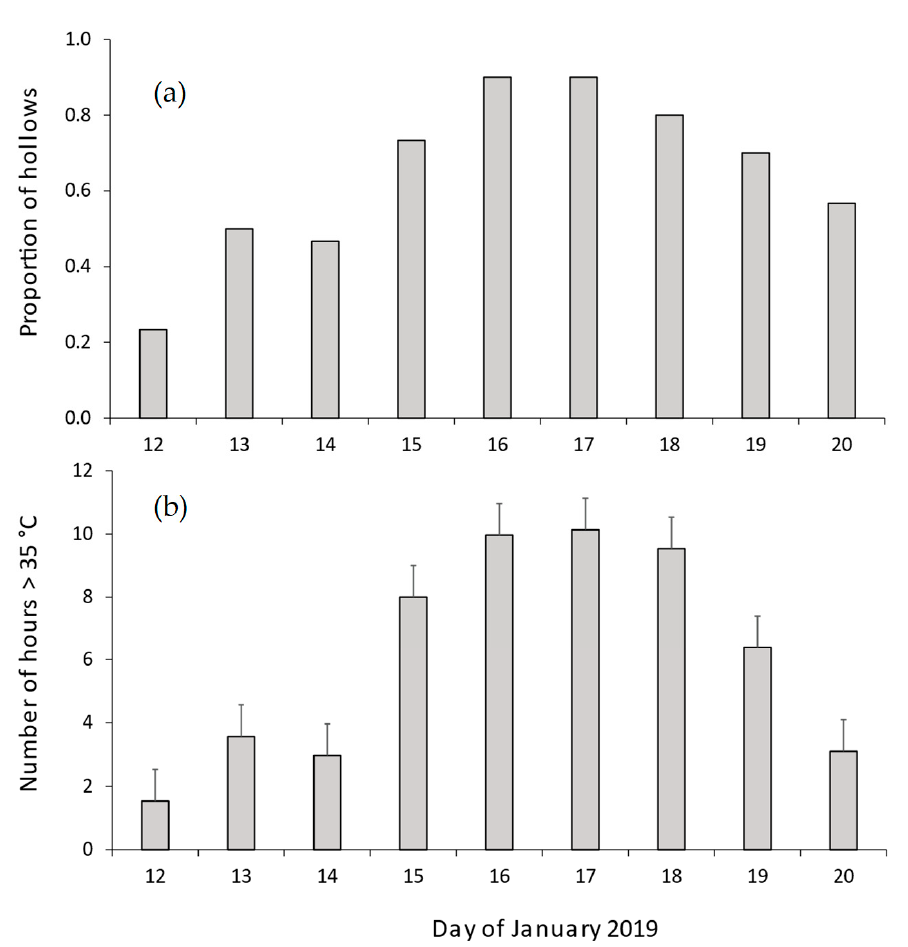
Figure 5. Thermal characteristics of CHs during the January 2019 heatwave. The figure shows ( a ) proportion of chainsaw-carved hollows where temperatures exceeded 35 °C for more than two hours per day and ( b ) the mean number of hours per day in which hollow temperatures exceeded 35 °C. Error bars in panel ( b ) denote standard errors.